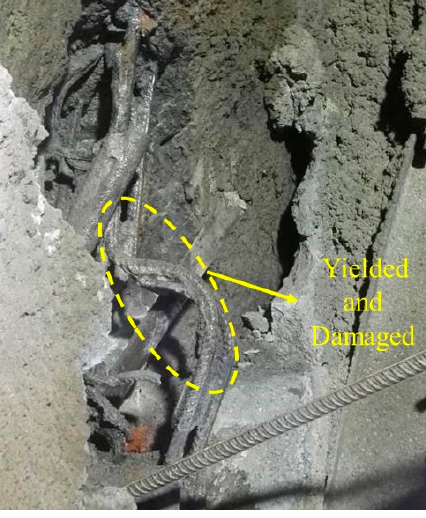
Figure 2. The initial support yielded and was damaged.